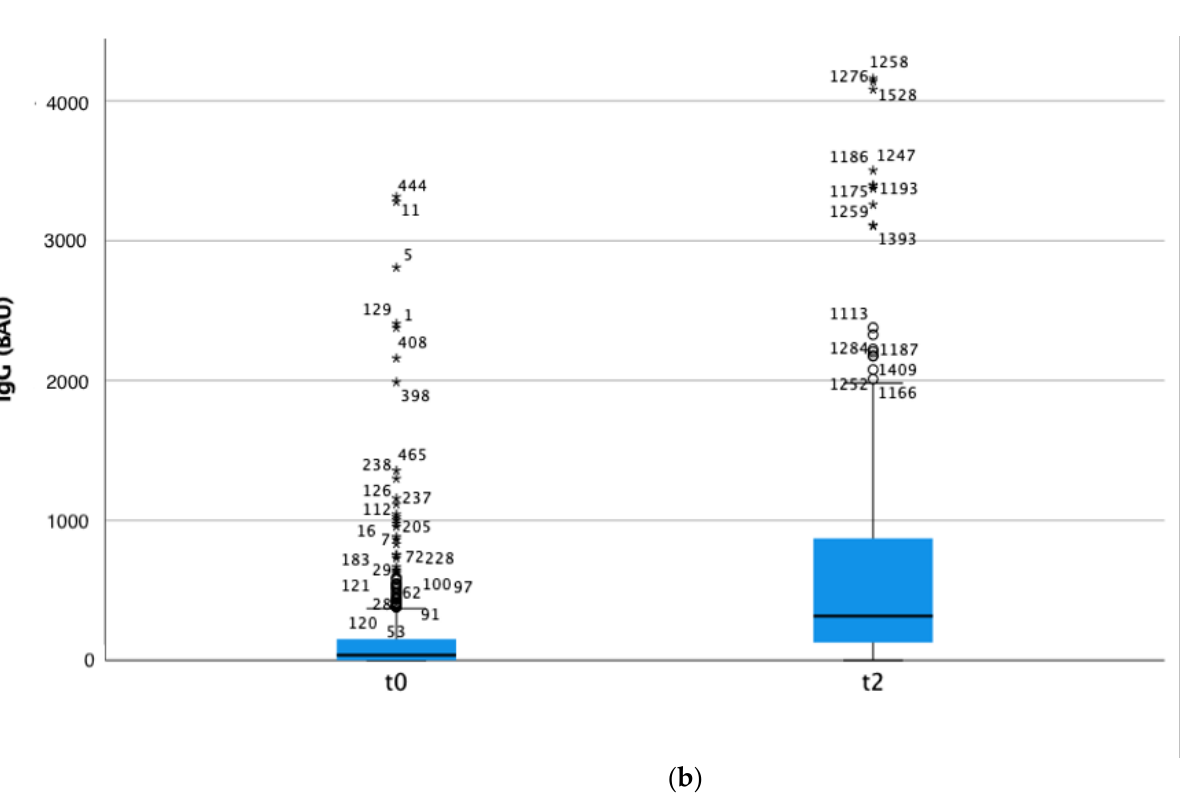
Figure 2. Box plots of anti-SARS-CoV-2 IgG titres (BAU/mL) among all study participants (t0: N = 534, t1: N = 404, t2: N = 314). ( a ) t0, t1 and t2; ( b ) t0 vs. t2. * and circles: outliers.